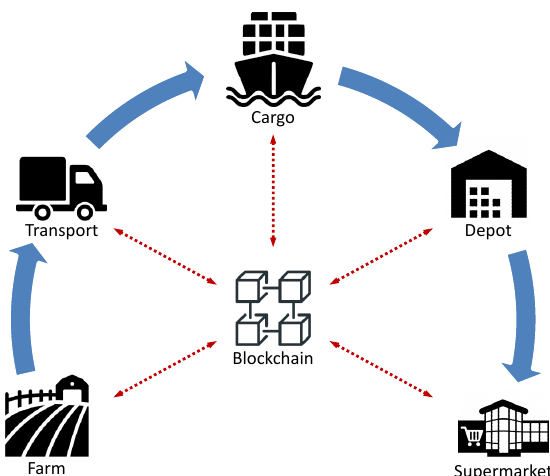
Figure 2. Food Supply-Chain: Data gathered from all stages of a food supply-chain are stored in a blockchain to provide dependable accountability with respect to proper handling of produce across the whole